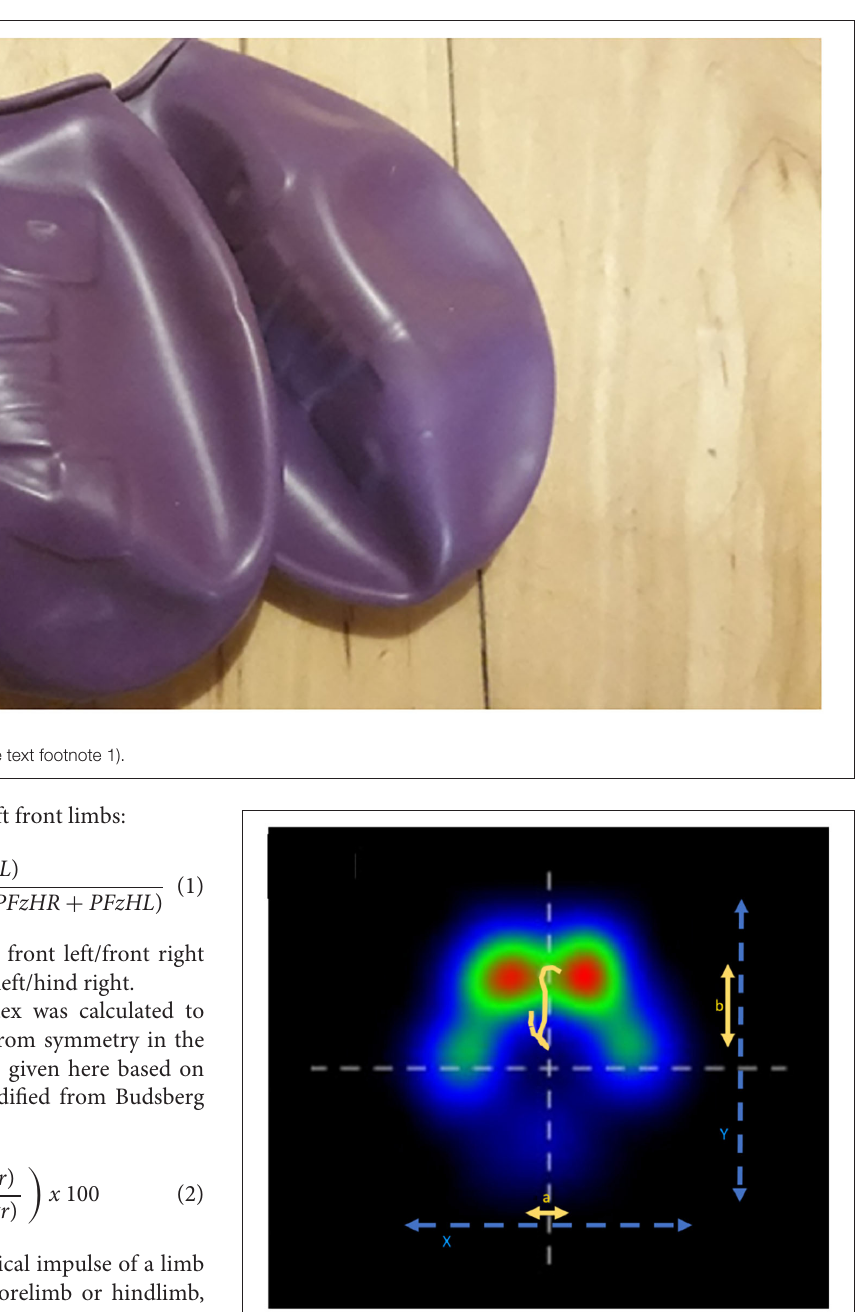
FIGURE 2 | Paw contact area and COP path, a: medio-lateral COP displacement, b: cranio-caudal COP displacement, X: maximum width of paw contact area, Y: maximum length of paw contact